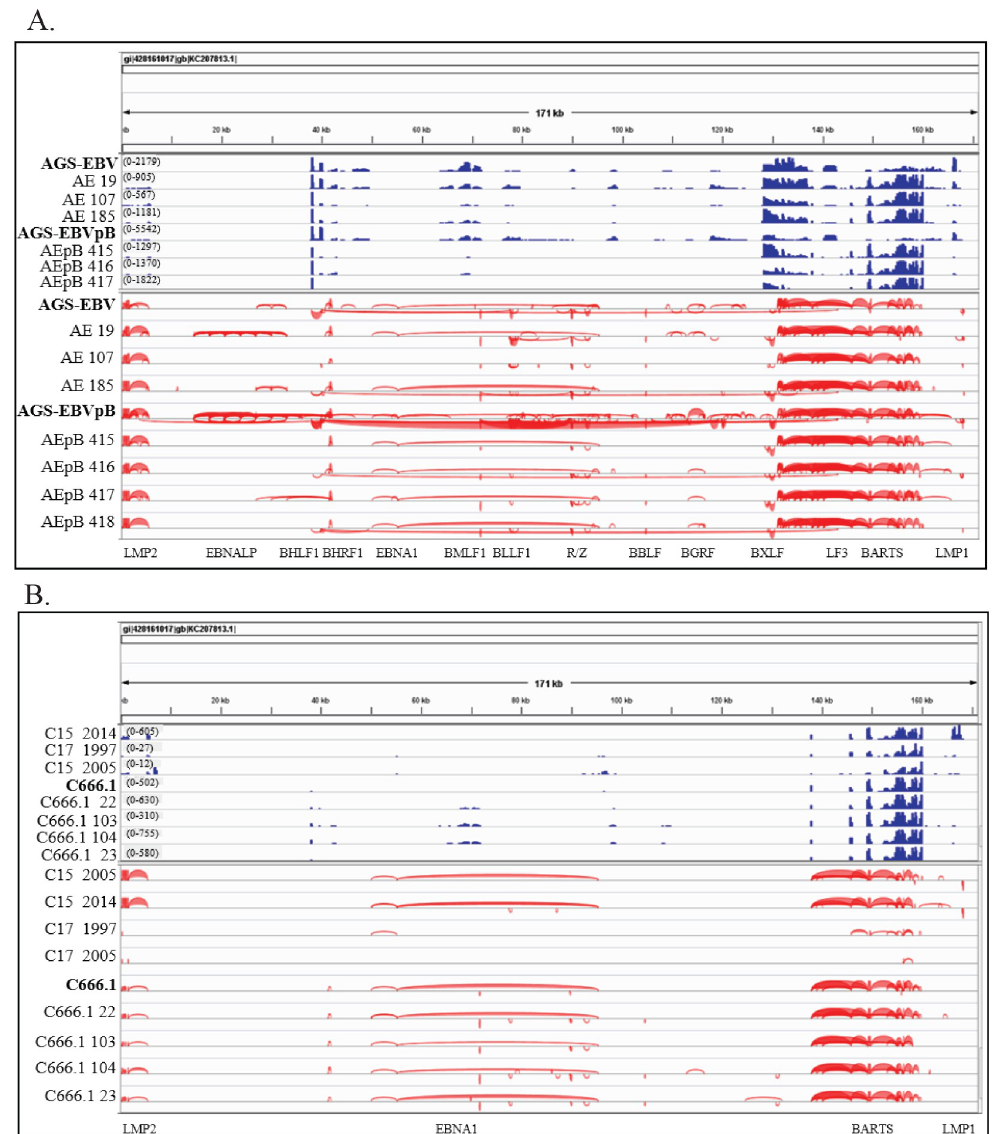
Fig 7. Visualization of the EBV reads and splice junctions. (A) Mapped reads and splice junctions of AGS-EBV cell lines and representative tumors mapped to the Akata genome. The scale in parentheses represents the number of reads with the height of the blue peaks also representing the abundance of reads. The EBV splice junctions are shown below in red with their corresponding EBV gene denoted on the bottom axis with the thickness of the red lines indicating the frequency of detection of specific splices. (B) Mapped reads and splice junctions of NPC cell line and tumors mapped to the Akata genome. The scale in parentheses represents the number of reads with the height of the blue peaks also representing the abundance of reads. The EBV splice junctions are shown below in red with their corresponding EBV gene denoted on the bottom axis with the thickness of the red lines indicating the frequency of detection of specific splices.